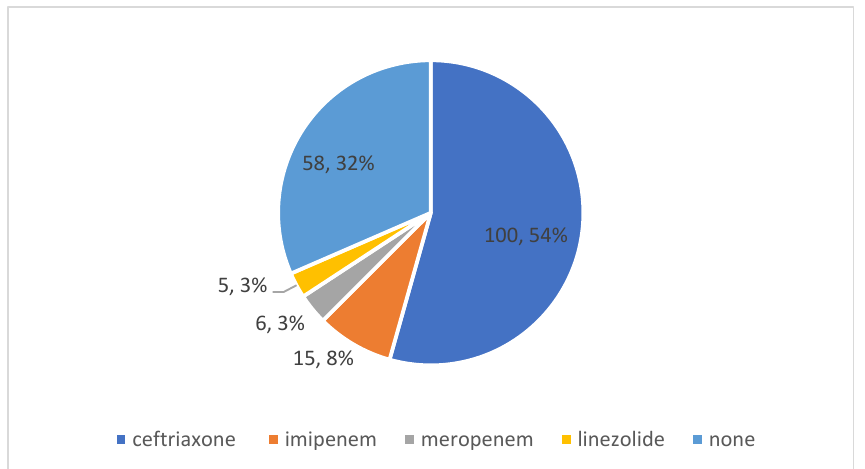
Figure 2. Antibiotics used in the ID ward.